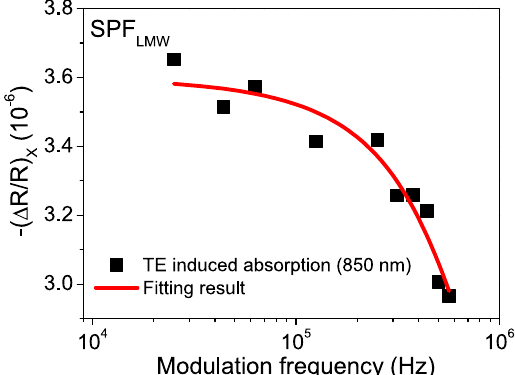
Figure 4. Modulation frequency dependence of PIA signal (850 nm) for SPF LMW at room temperature. The solid line shows fit to Equation 4. The average τ TH0 and C TH0 (over three samples) are about 680 ns and 3.67 × 10 − 6 for SPF LMW , respectively. The PIA measurement was carried out in device geometry with the structure ITO/ PEDOT:PSS/emitting layer/TPBI/Ca/Al.